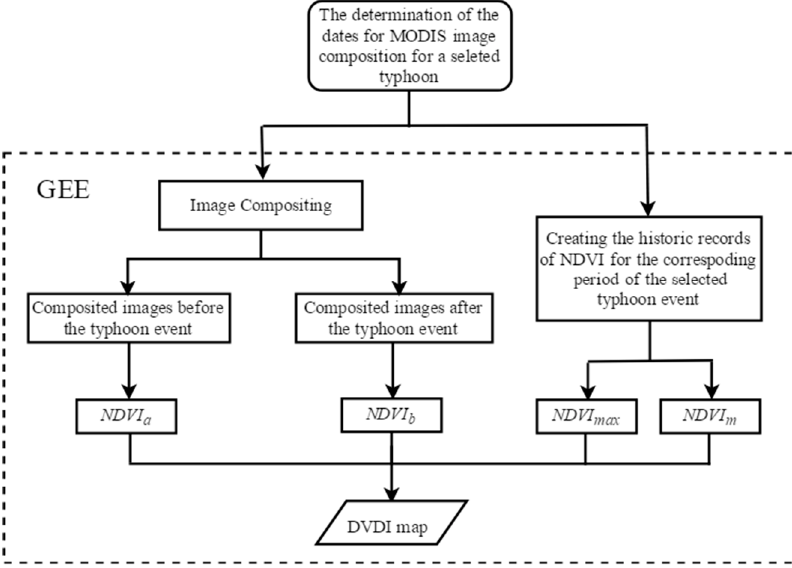
Figure 3. The flowchart for calculation of disaster vegetation damage index ( DVDI ) in Google Earth Engine (GEE).